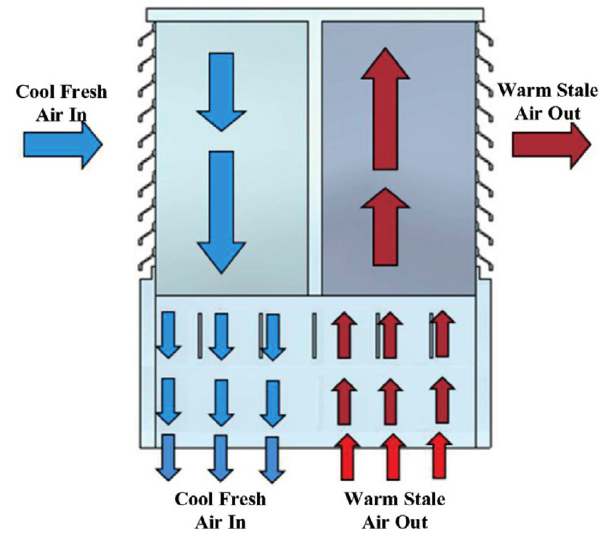
Figure 1. Schematic of typical wind tower